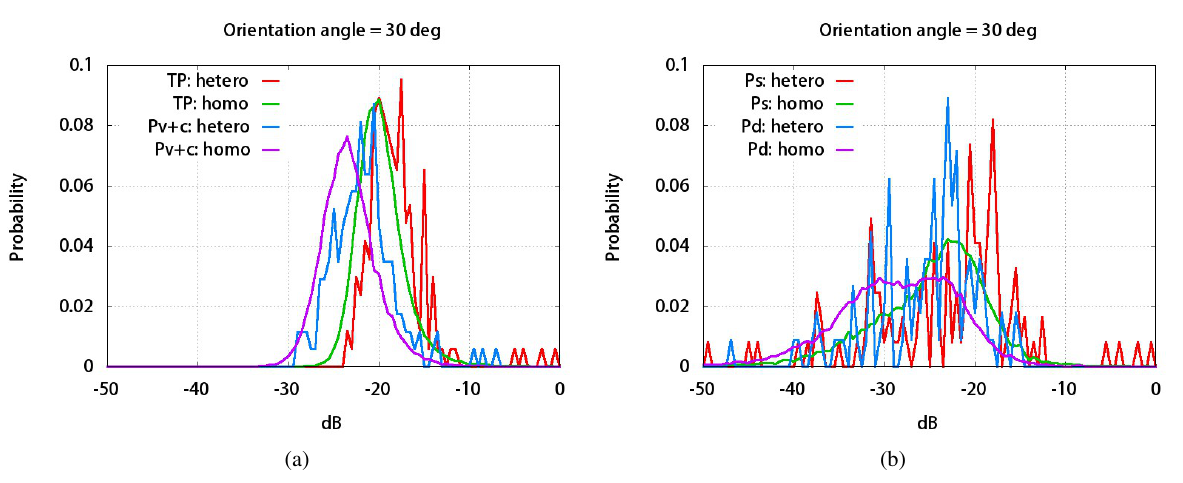
Figure 11. Histograms of scattering of areas having POA around 30 ◦ (28 ◦ (cid:20) POA (cid:20) 32 ◦ ) from PALSAR image of the study area. See the caption of Fig